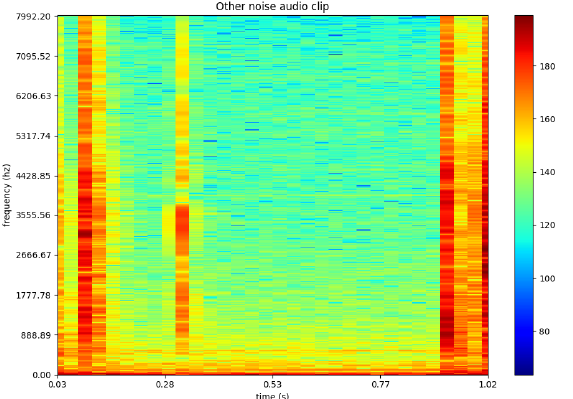
Figure 4. Example of other noise in spectrogram representation © [2019] IEEE. Reprinted, with permission, from